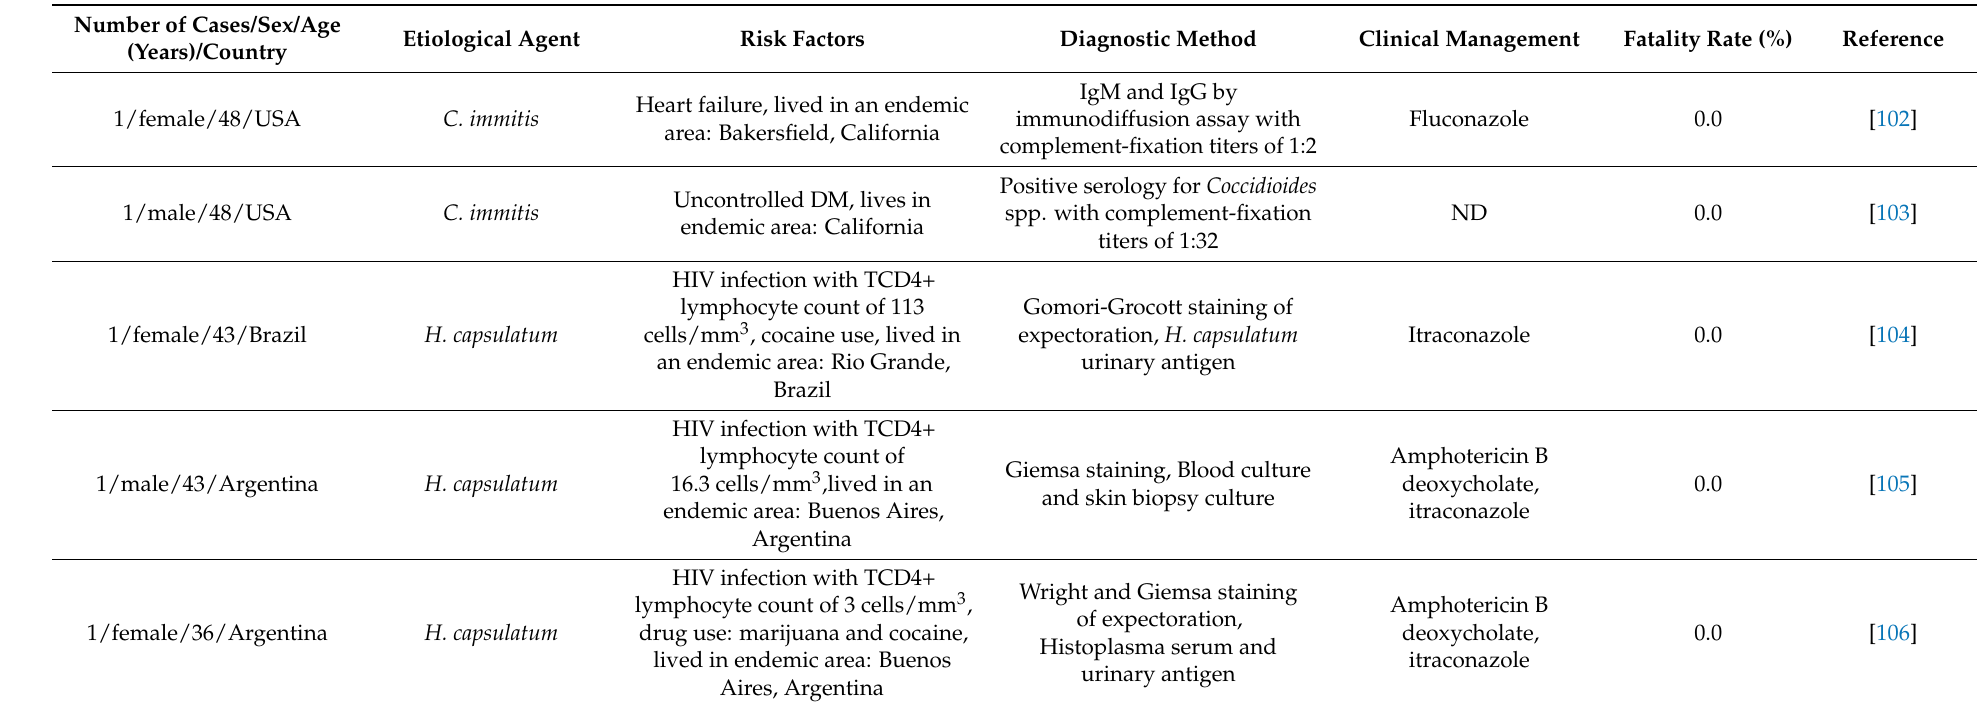
Table 5. Cases of COVID-19 and endemic mycosis